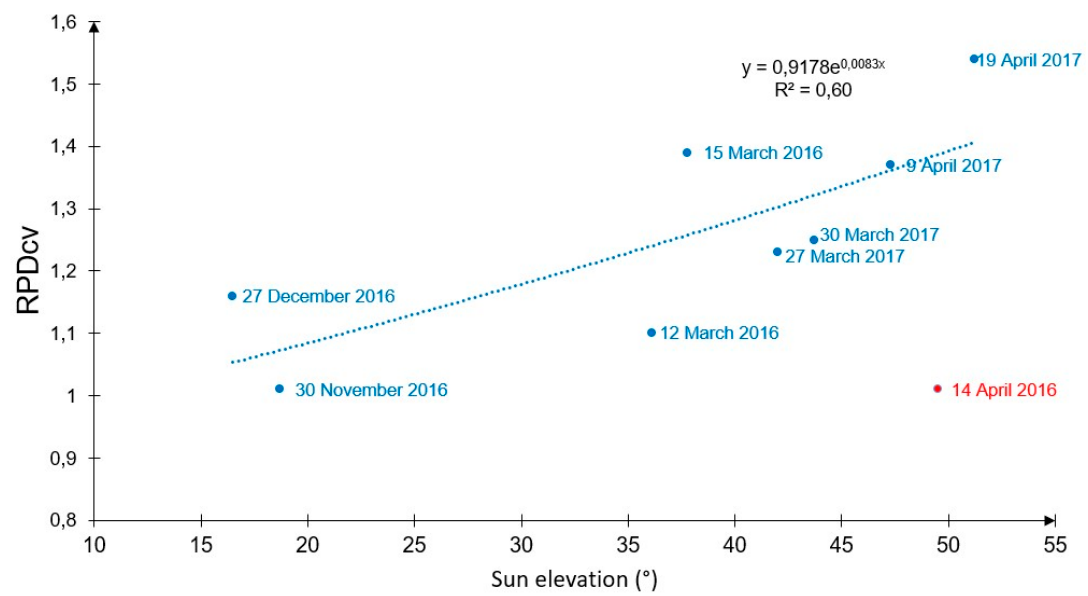
Figure 3. Plot of RPDcv against sun elevation and regression equation, excluding 14 April 2016.